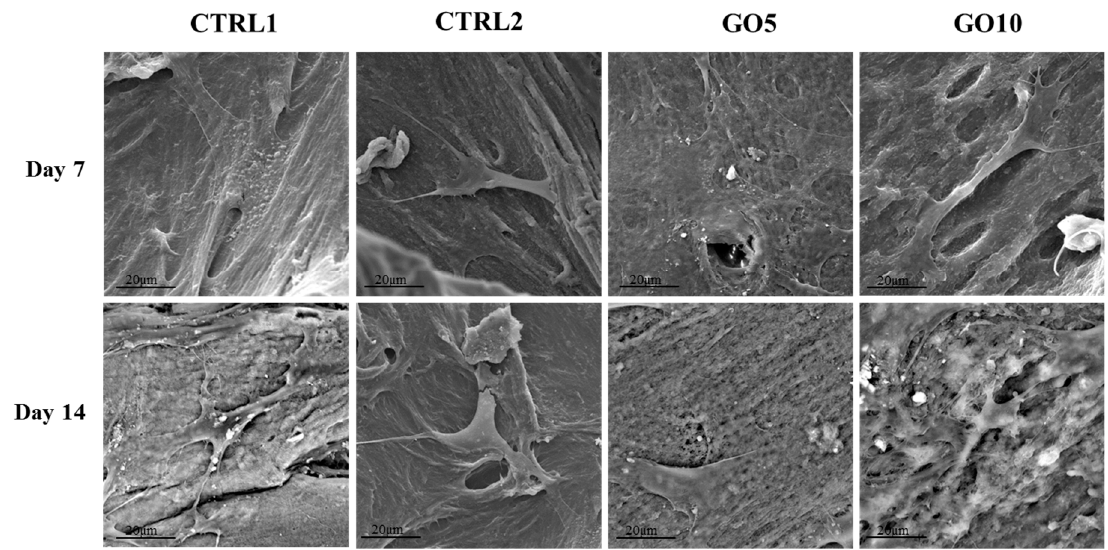
Figure 5. SEM images of Dental Pulp Stem Cells (DPSC)) cultured on bare Laminas (CTRL1), APTES- treated (CTRL2), 5 µg/mL GO-coated (GO5) and 10 µg/mL GO-coated (GO10) Laminas for 7 and 14 days. Magnification 3000×.